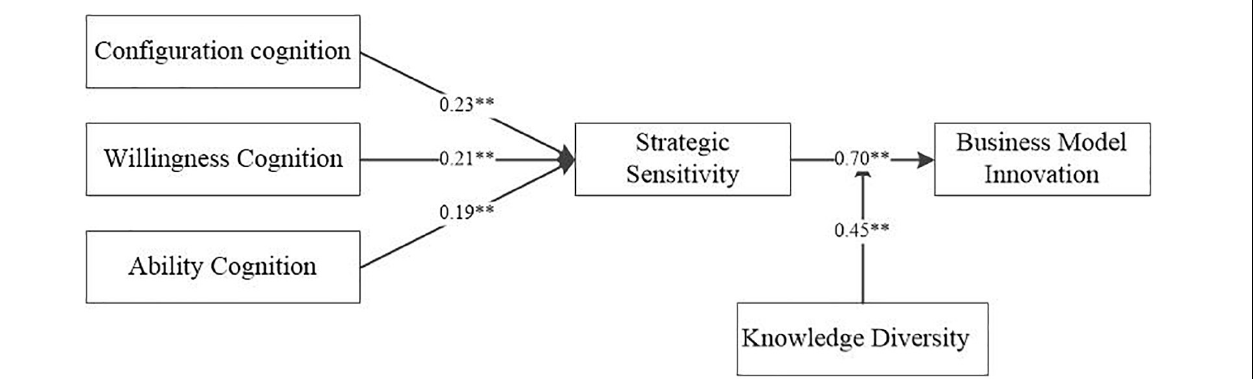
FIGURE 2 | Hypothetical test results. **Significant at the p < 0.01